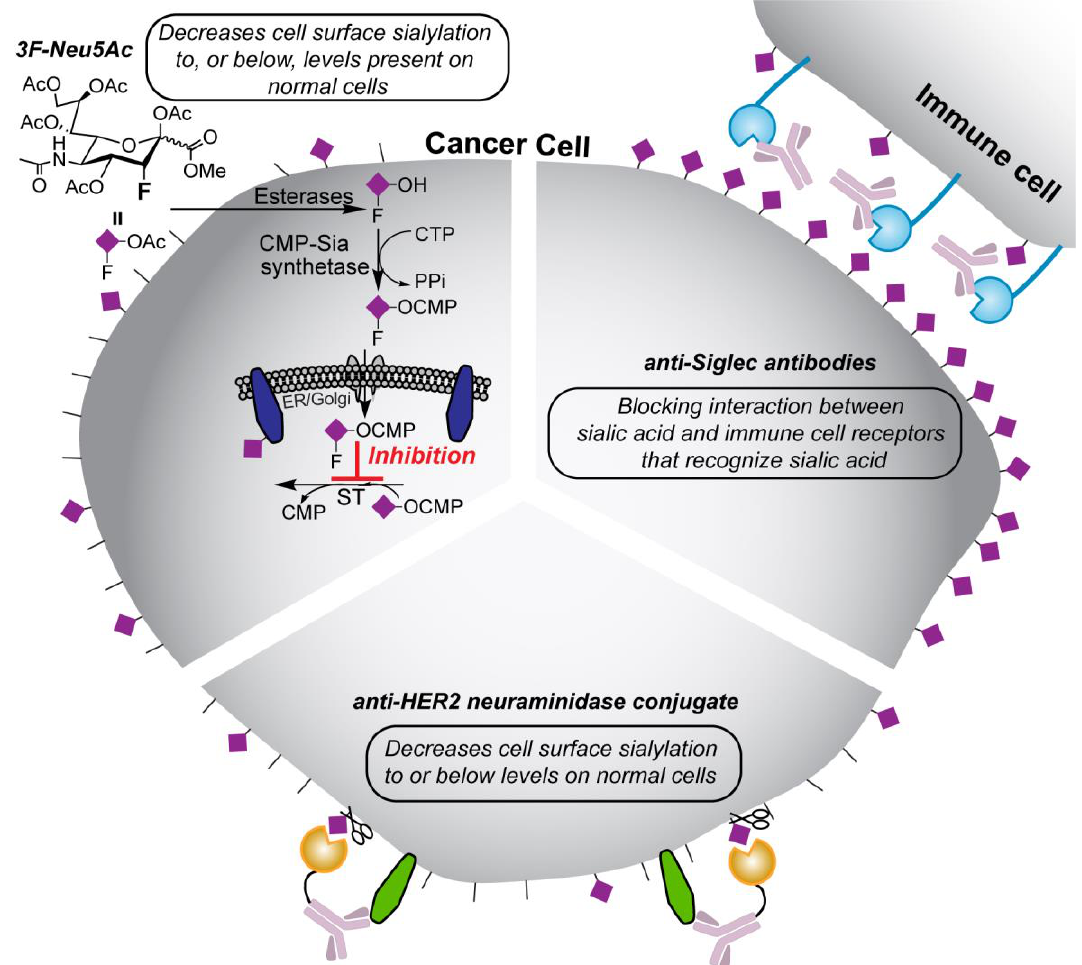
Figure 3. Therapeutic strategies for modulating sialic acid expression and interactions between sialic acid and sialic acid-binding receptors. ( Upper left portion of cell ): delivery of 3F-Neu5Ac to cancer cells to decrease sialic acid expression. 3F-Neu5Ac is typically delivered in its peracetylated form to penetrate the cell membrane. Once inside the cell, 3F-Neu5Ac is converted into CMP-3F-Neu5Ac and blocks the actions of STs in the secretory pathway. ( Upper right portion of cell) : blocking antibodies that abrogate the interaction between sialic acid on cancer cells and sialic acid-binding receptors on immune cells, such as Siglecs, have the potential of being a new class of immune checkpoint inhibitor. ( Lower portion of the cell ): antibody directed to the tumor, such as anti-HER2 to target breast cancer cells, have been conjugated to neuraminidase to cleave the sialic acid residues on the cancer cells.